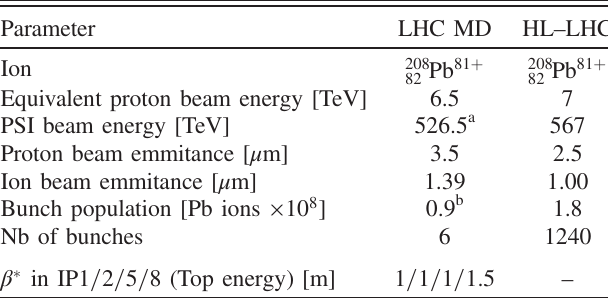
TABLE I. Collection of beam and machine parameters used in experiments with 208 Pb 81 þ and for the simulated beam in the S ix T rack – FLUKA setup. The HL – LHC beam parameters are taken from Ref.